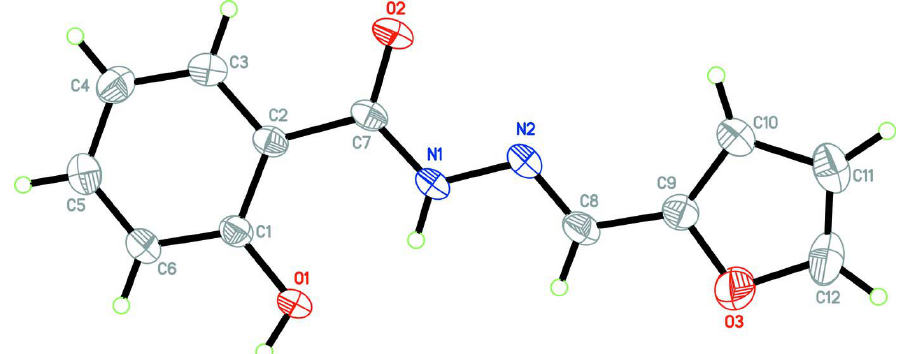
Figure 1 The molecular structure of (I), with displacement ellipsoids drawn at the 50% probability